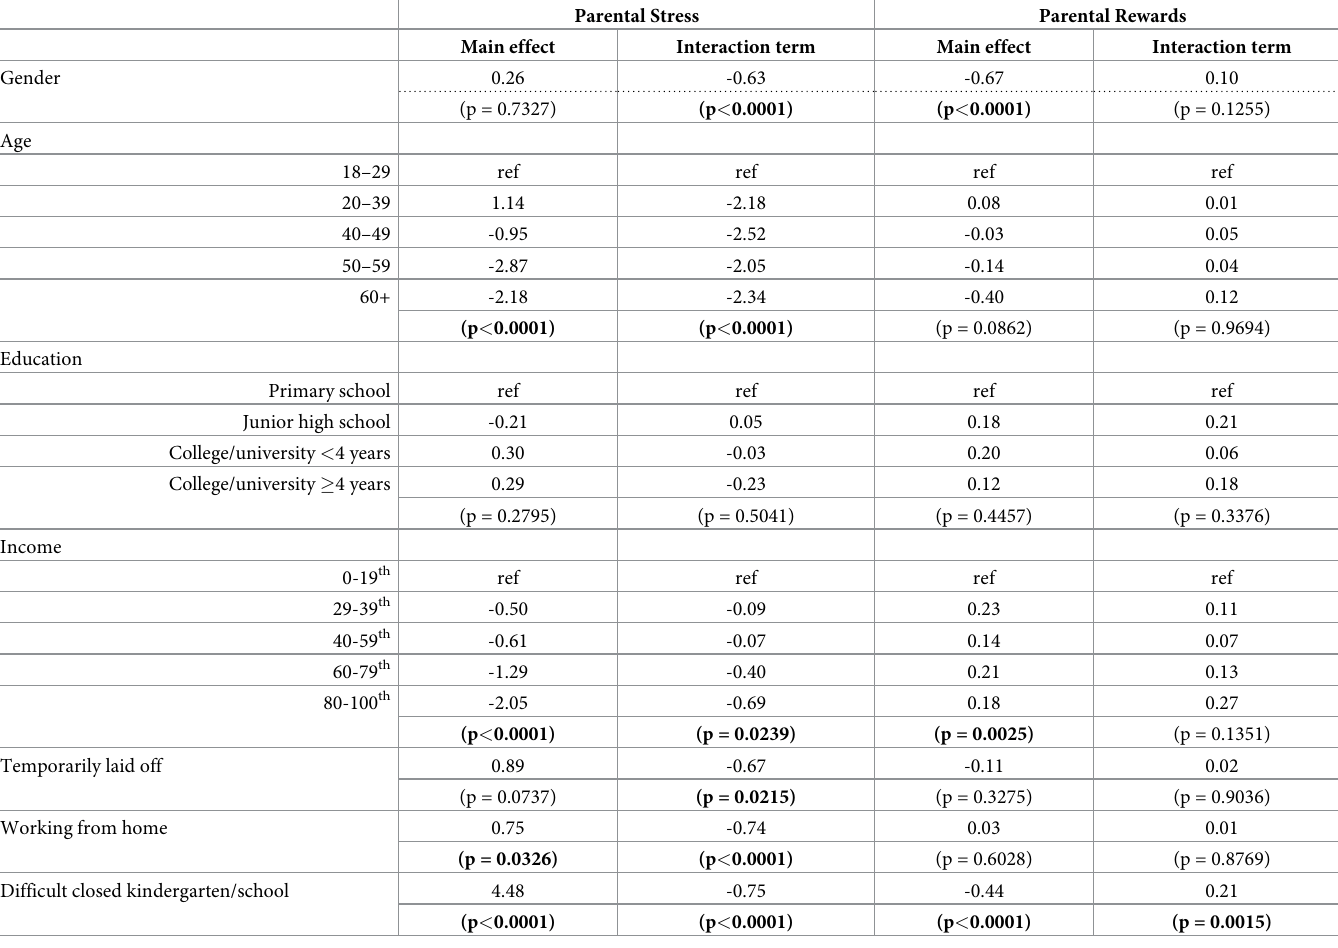
Table 3. Interaction of parent’s gender, age, education, family income and COVID-19 control measures on parental stressors and rewards. Each interaction term entered into separate